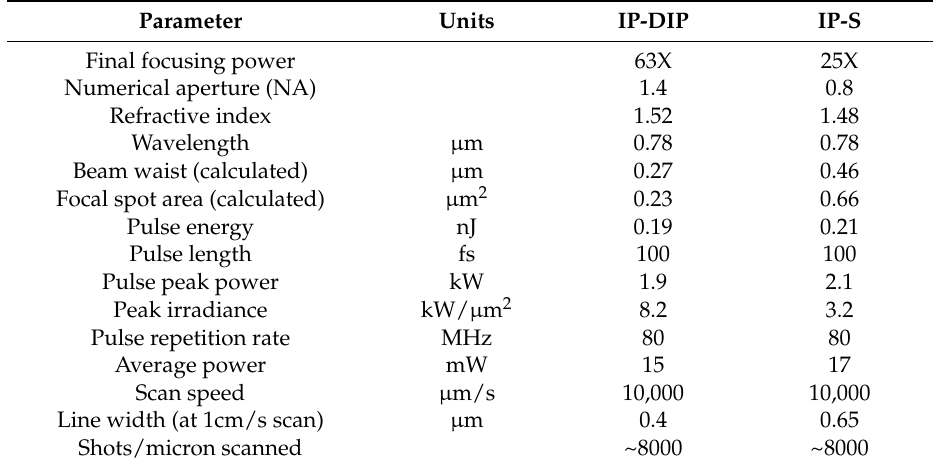
Table 2. Top level summary of typical 2PP writing conditions used to prepare low-density structures reported in this